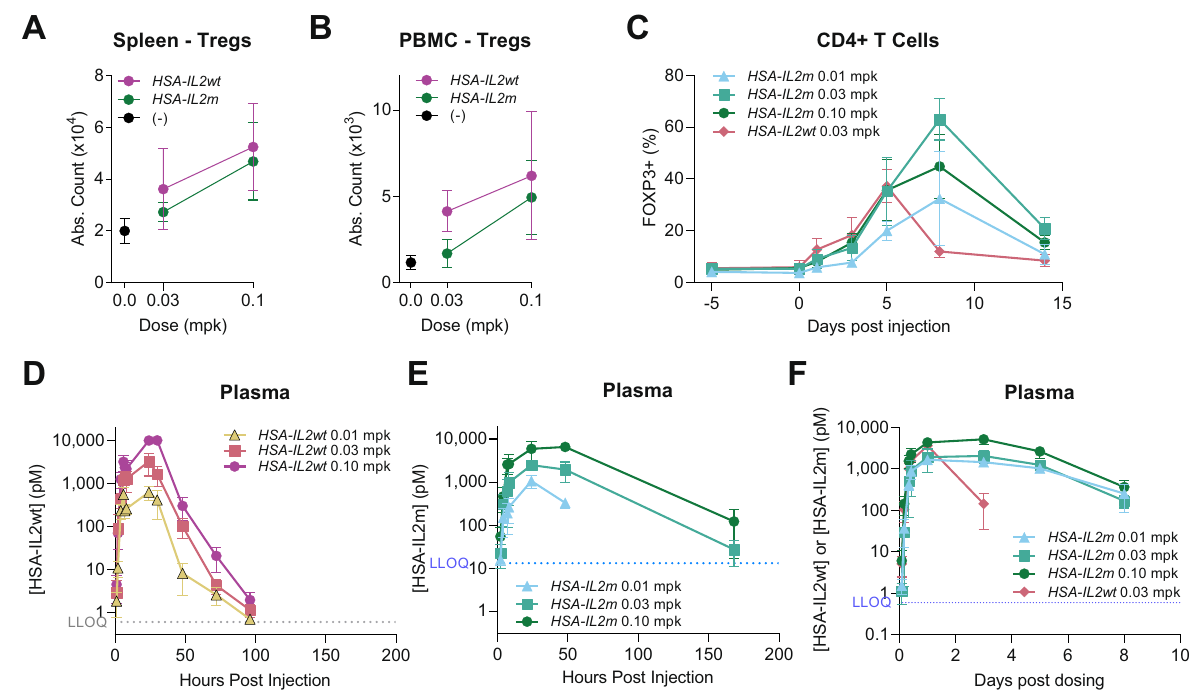
Fig. 2 Extended Treg expansion with HSA-IL2m treatment. Treg counts in A spleen and B blood of C57BL/6 female mice following treatment with HSA- IL2wt and HSA-IL2m ( n = 5). C Time course of Treg frequency among CD4 + T cells in blood of cynomolgus monkey following treatment with HSA-IL2m and HSA-IL2wt ( n = 4). Plasma concentration of D HSA-IL2wt and E HSA-IL2m in C57BL/6 mice ( n = 5). F Plasma concentration of HSA-IL2wt and HSA- IL2m in cynomolgus monkey ( n = 4). Data are presented as mean ± s.d. LLOQ = Lowest limit of quanti fi cation. Source data are provided as a Source Data fi